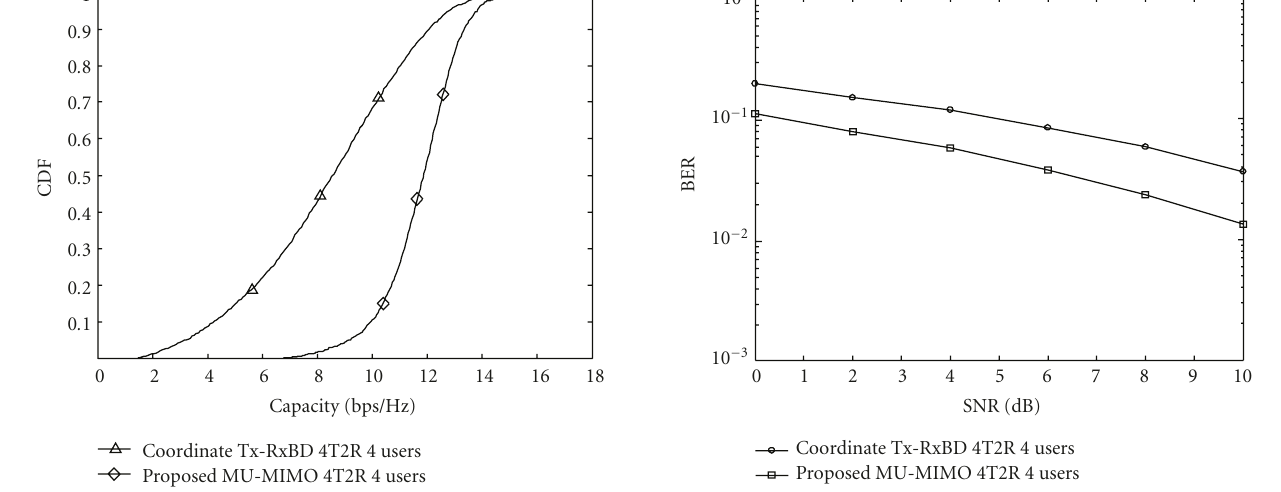
Figure 5: The system capacity CDF comparison of the two schemes.